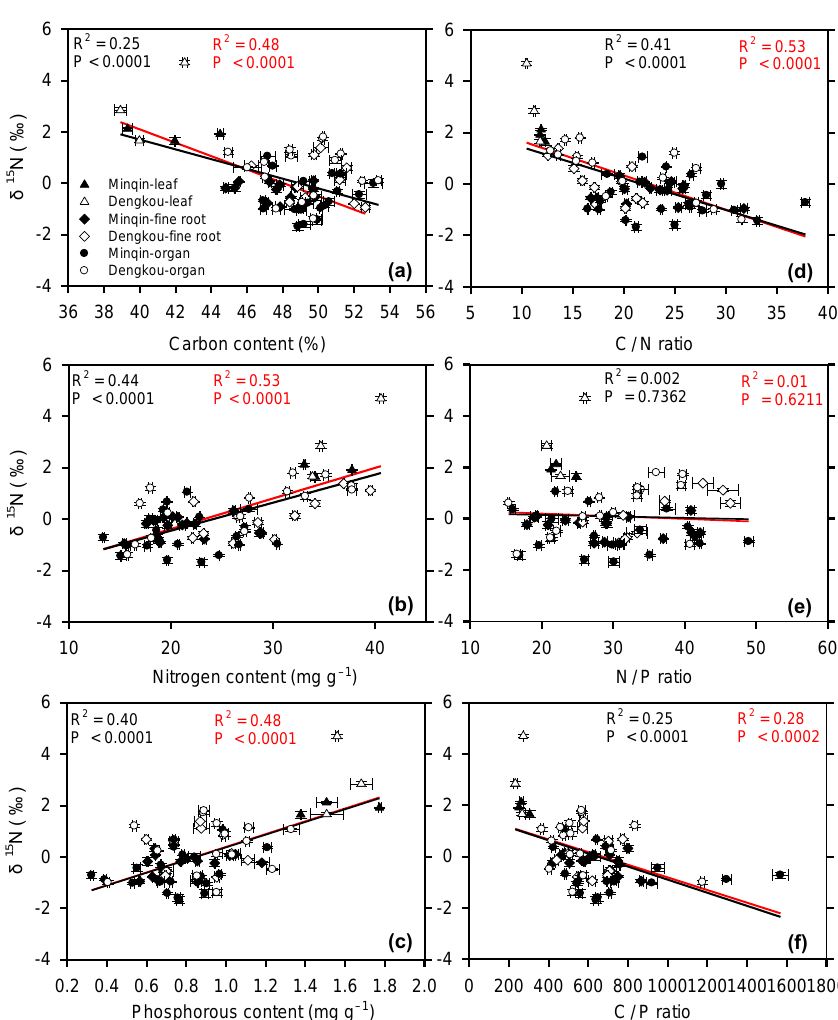
Figure 3. Changes of δ 15 N as a function of organ contents of carbon (a) , nitrogen (b) , and phosphorous (c) and of organ ratios of carbon to nitrogen (d) , nitrogen to phosphorous (e) , and carbon to phosphorus (f) . Filled and unfilled symbols represent organs at the Minqin and Dengkou sites, respectively. Leaves are denoted by filled or unfilled triangles while other organs by filled or unfilled circles. The black regression lines are for all organs while for the red regression lines, data of fine roots are not